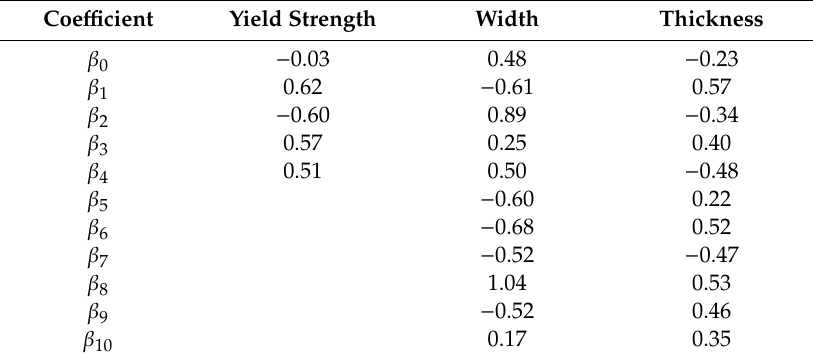
Table 8. Model coe ffi cients ( β 0 – β 10 ) for the estimation of each strip property.